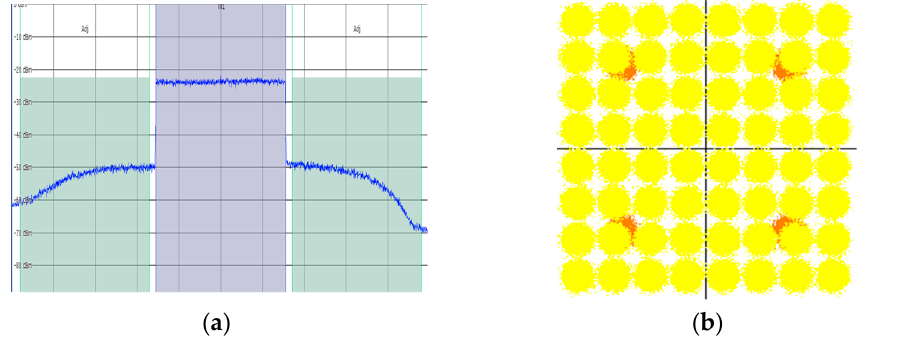
Figure 12. Measurement results of linearity: (a) output spectrum and (b) constellation for 25 GHz 64-QAM CP-OFDM modulated signal with 100 MHz channel bandwidth under EVM − 25 dBc con- dition.